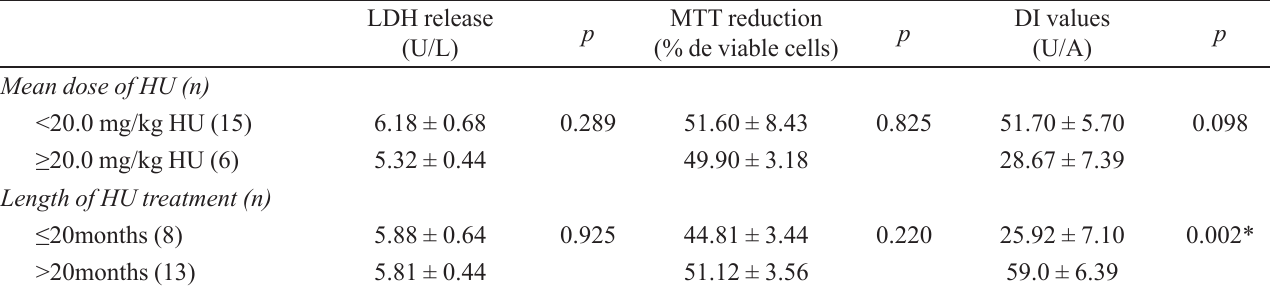
Results were expressed as mean ± SEM. Student t-Test. * p